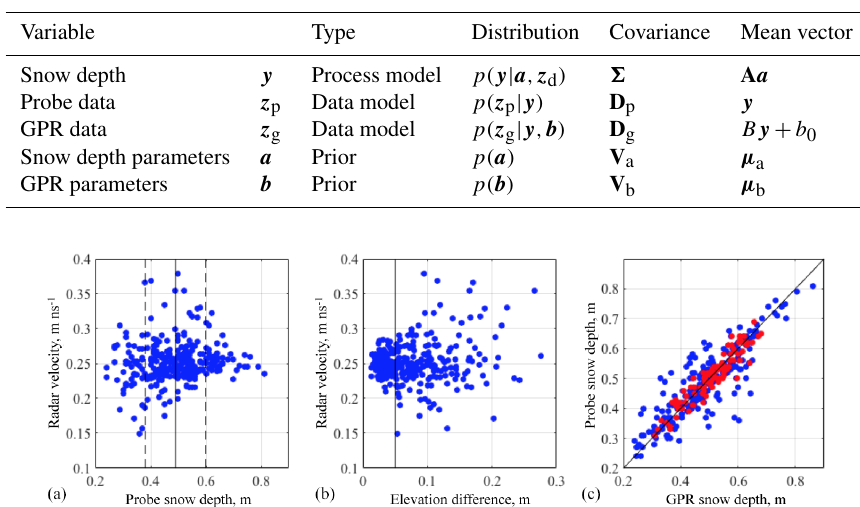
Figure 2. Radar velocity as a function of (a) co-located snow depth measured by a snow depth probe and (b) elevation difference (i.e., topographic variability) within 1m. (c) Comparison between the probe-derived and GPR-derived snow depth at all the co-located locations (blue circles) and at selected locations (red circles) where topographic variability is low. In (a) , the black vertical line is the median snow depth, and the dotted lines are ± 1 SD from the median snow depth. In (b) , the black line is the cutoff elevation difference of